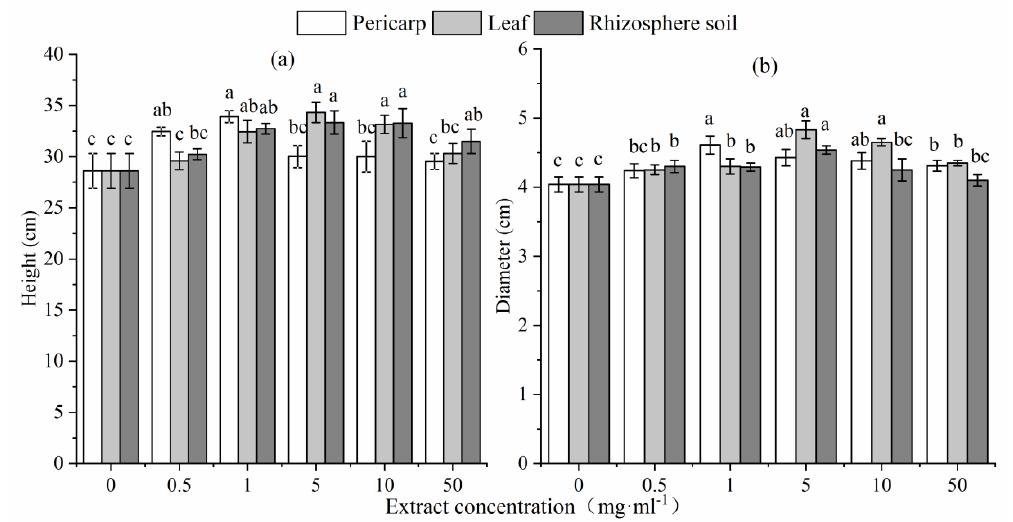
Figure 2. Height ( a ) and ground diameter ( b ) of L. formosana seedlings following treatment with different concentrations of C. migao pericarp, leaf, and rhizosphere soil aqueous extracts. Lowercase letters represent significant differences in each treatment group ( p < 0.05).